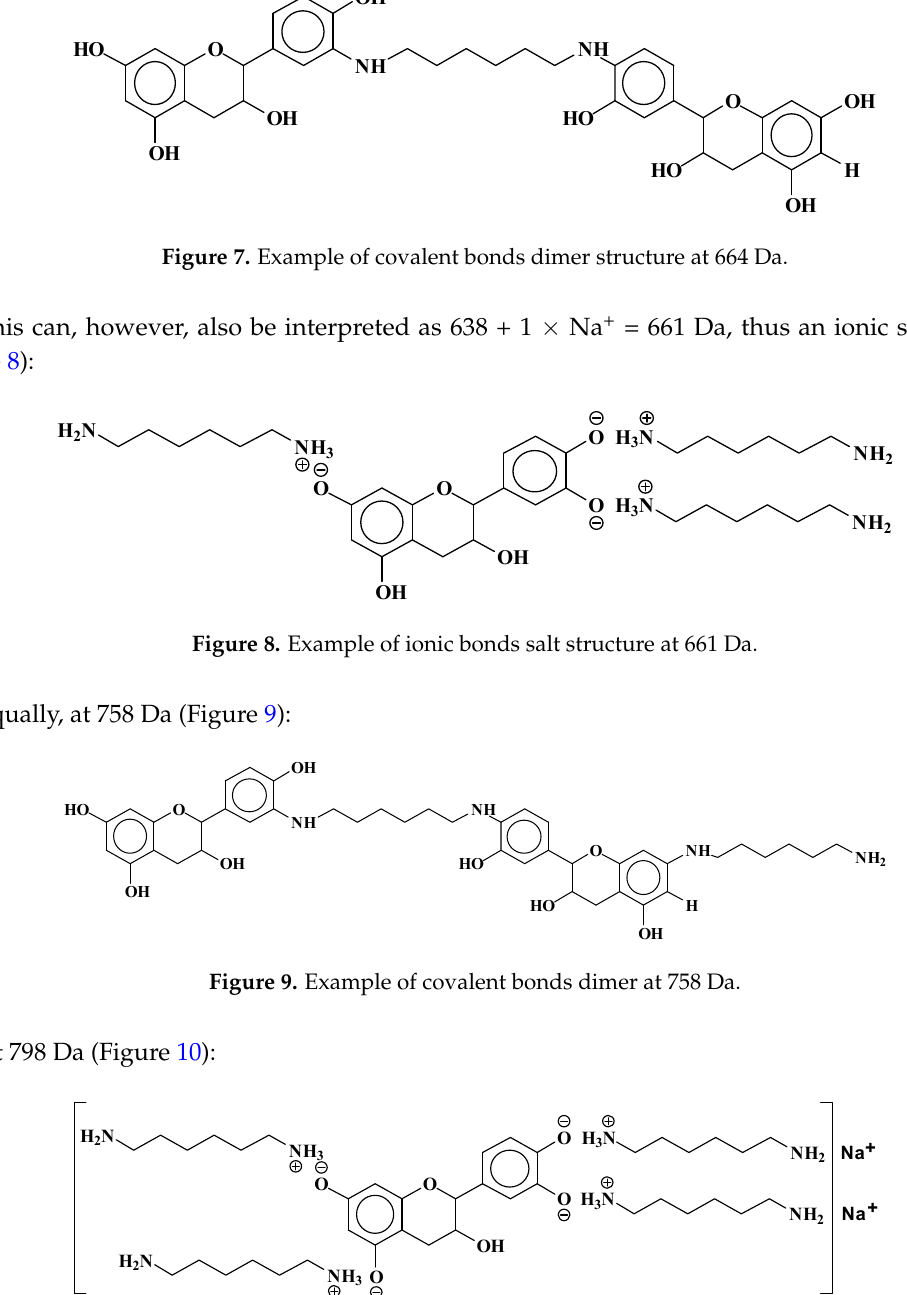
Figure 10. Example of ionic bonds salt structure at 798 Da.